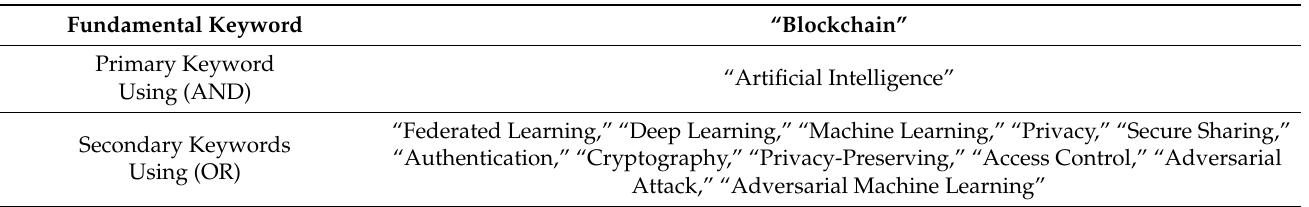
Figure 3. Methodological Framework. Table 1. List of Primary and Secondary Keywords for Search